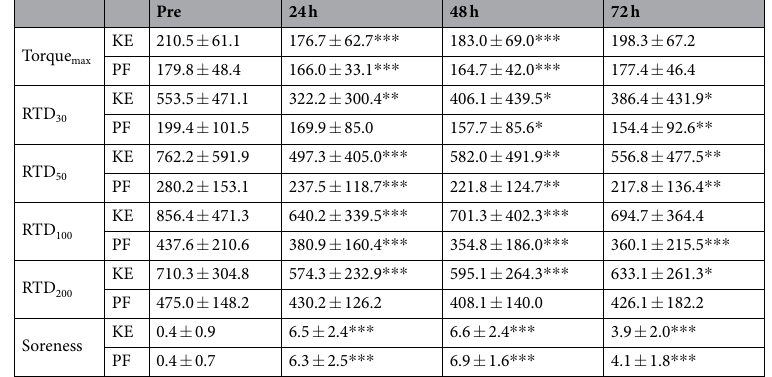
Table 2. Maximal torque (Nm), RTD (Nm/s), and soreness before and 24, 48, and 72 h after downhill running. * , ** , *** :Significantly different from pre at P < 0.05, P < 0.01, and P < 0.001, respectively. Torque max : maximal torque, KE: knee extensors, PF: plantar flexors, RTD 30, 50, 100, 200 : rate of torque development in the time intervals of 0–30, 0–50, 0–100, and 0–200 ms, respectively, from contraction